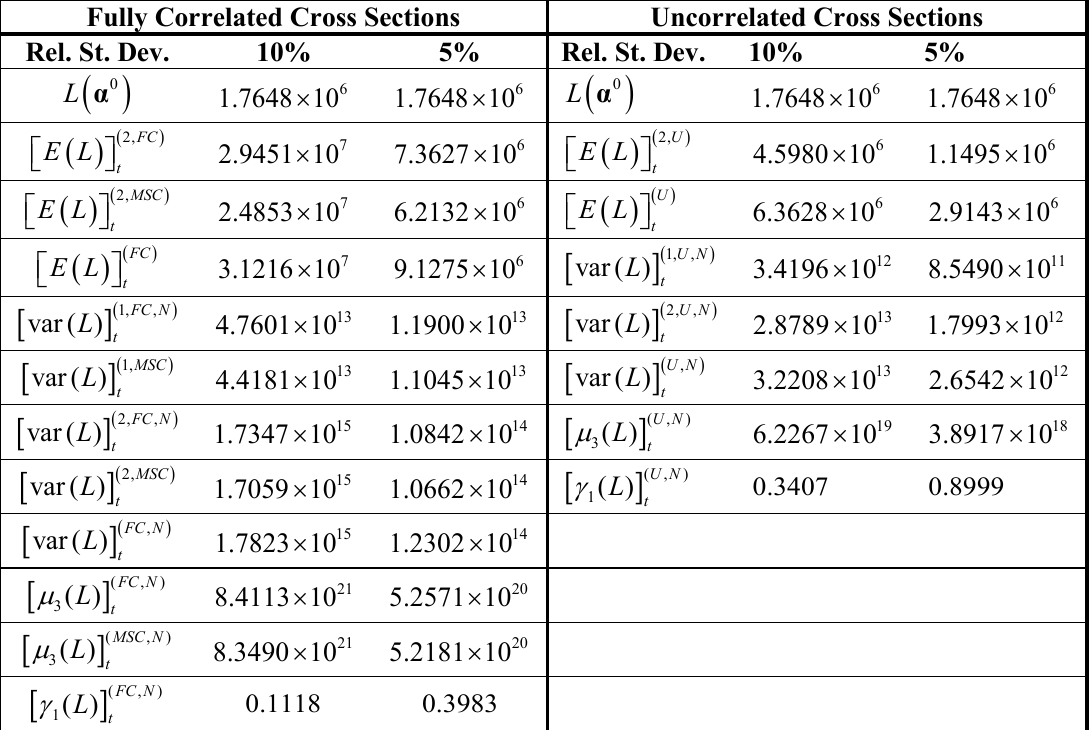
Table 4 Response moments for various relative standard deviations of total microscopic cross section which are fully